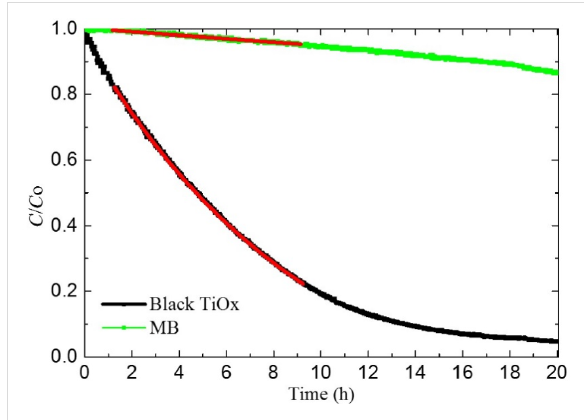
Figure 6: UV discoloration of methylene blue (MB) dye in the pres- ence of TiO x /Ti/Pt foil. The discoloration of a MB solution without photocatalyst is also reported for comparison purposes.